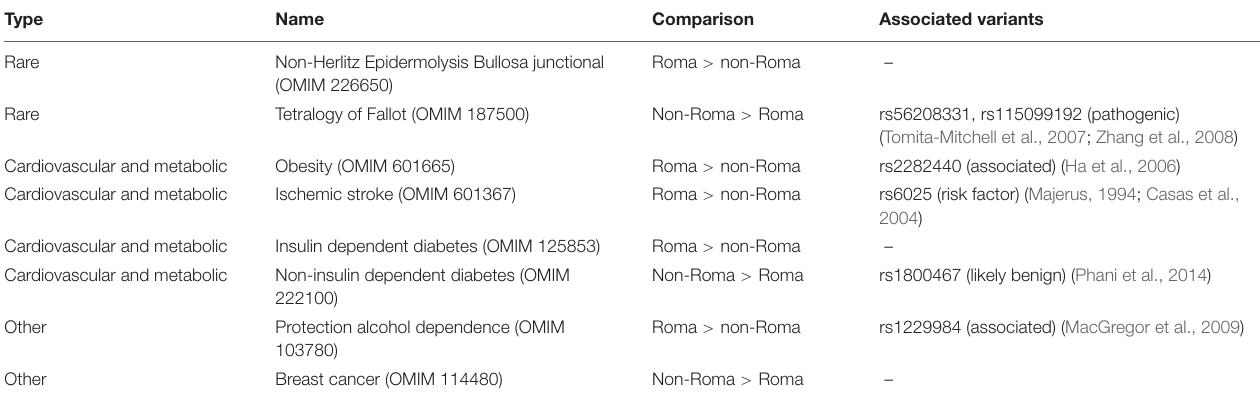
TABLE 1 | Summary results of the overrepresentation